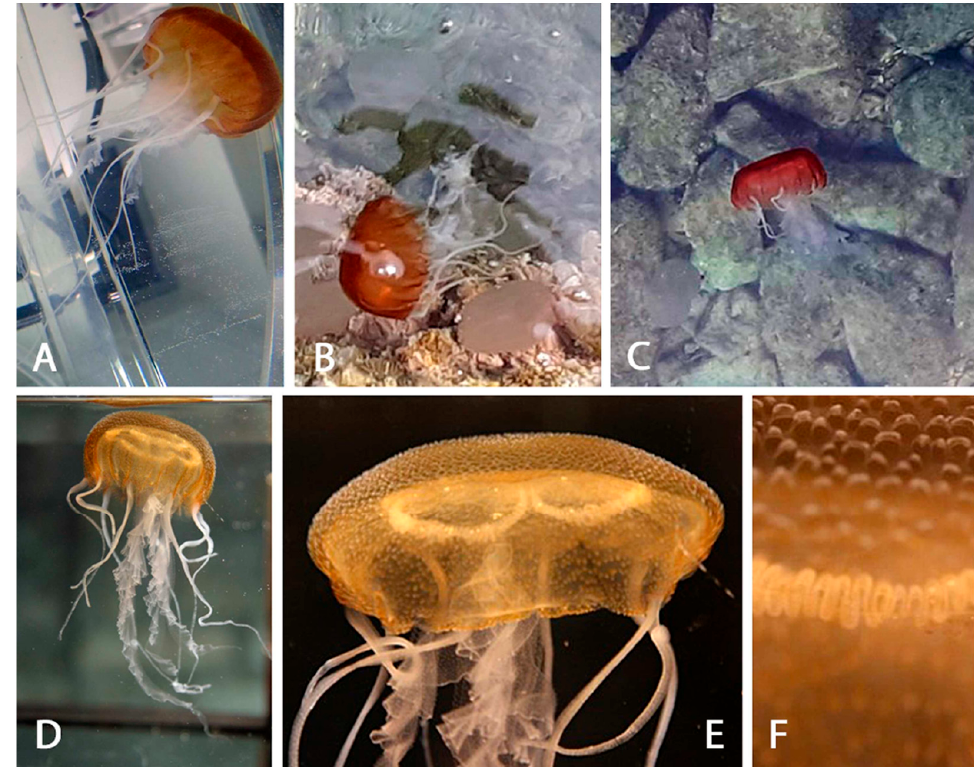
Figure 1. Recent observations of Mawia benovici in the Adriatic Sea: ( A ) Bay of Piran (Slovenia) on 18 December 2018; ( B , C ) near Rovinj (Croatia) on 27 November and 1 December 2020, respectively: in these images, Mawia benovici is surrounded by Mnemiopsis leidyi ctenophores; ( D ) in front of the Piran Aquarium on 27 December 2020; ( E ) detail of the umbrella of the specimen in ( D ); and ( F ) magnification of the gonadic ribbon of specimen in ( D ).